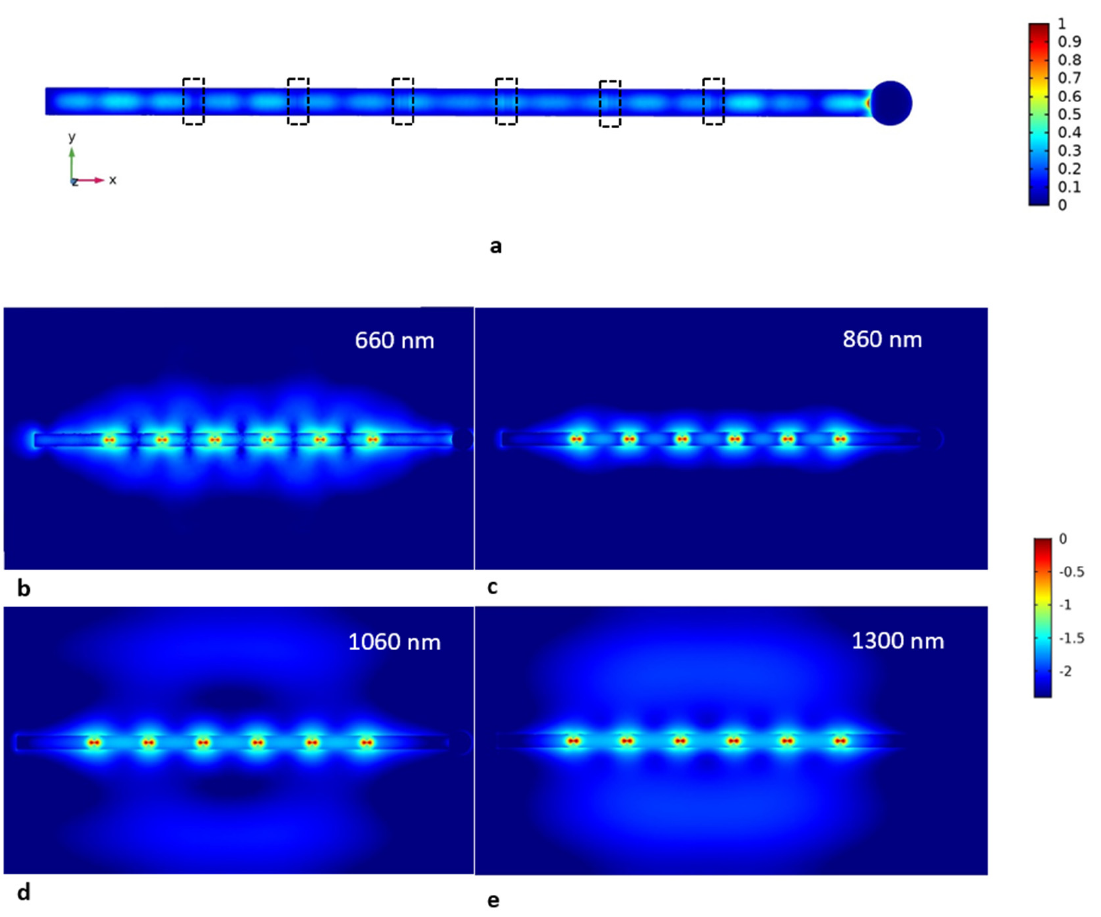
Figure 4. ( a ) Distribution of the electric field in a 4 µm NW with 6 GaPAs insertions (highlighted with a dashed line) excited by 532 nm plane wave travelling along the Z axis and polarized along the X axis. The map shows the field distribution along the center plane of the NW parallel to the substrate surface (XY). The plot is normalized (E/E 0 ), where E is the field at a given point and E 0 is the applied field. Due to the small size of the insertions and low GaP-GaPAs optical contrast, the field distribution is weakly distorted, and NDs are not distinguishable on the map; ( b – e ) 4 µm long NW with 6 GaPAs NDs separated by 600 nm GaP segments; each ND is simulated with 50 nm dipole, polarized along the X axis emitting at 650 ( b ), 860 ( c ), 1060 ( d ) and 1300 nm ( e ). The plot is log scale of the normalized field (E/E 0 ) to demonstrate faint coupling of the emitters.